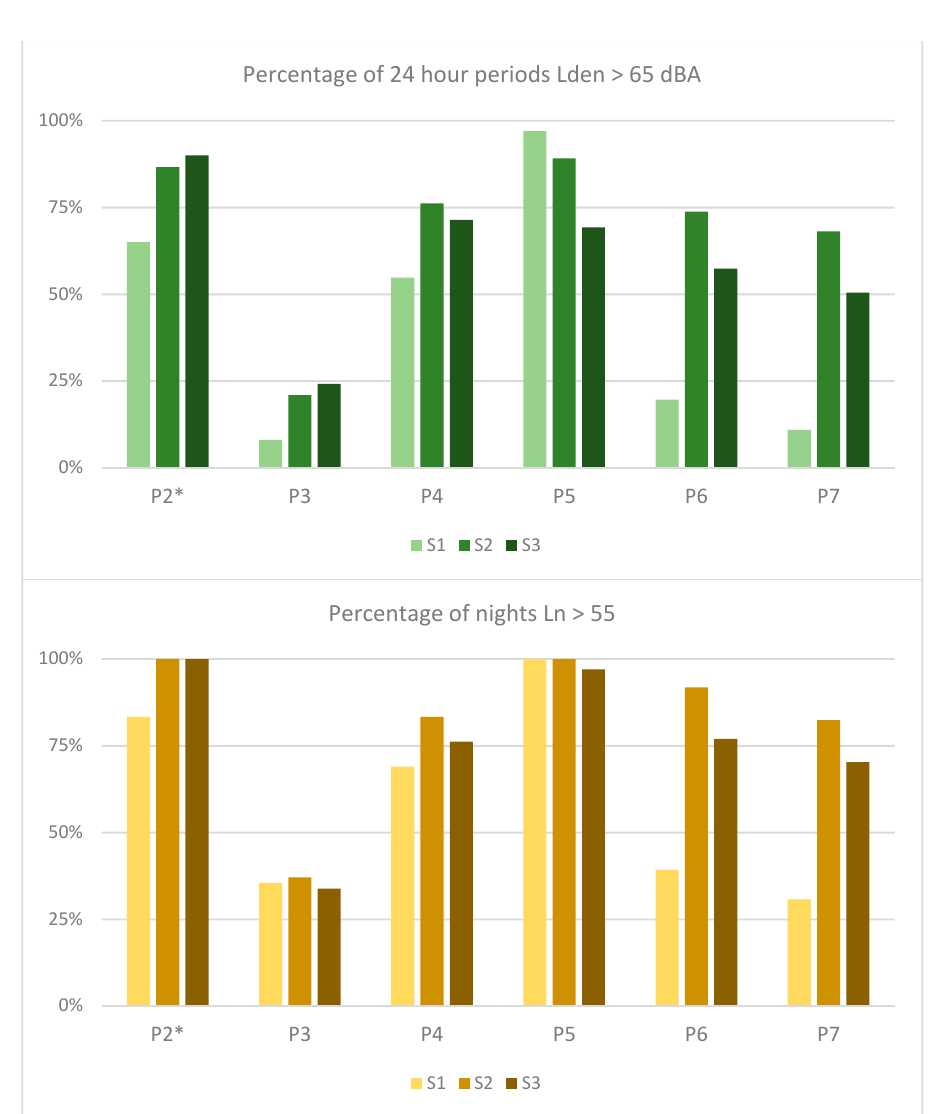
Figure 8. Percentage of days by site and by time period where Lden > 65 dBA and where Ln > 55 dBA. * Please note that P2 data does not cover the whole period due to the measurement network being offline.